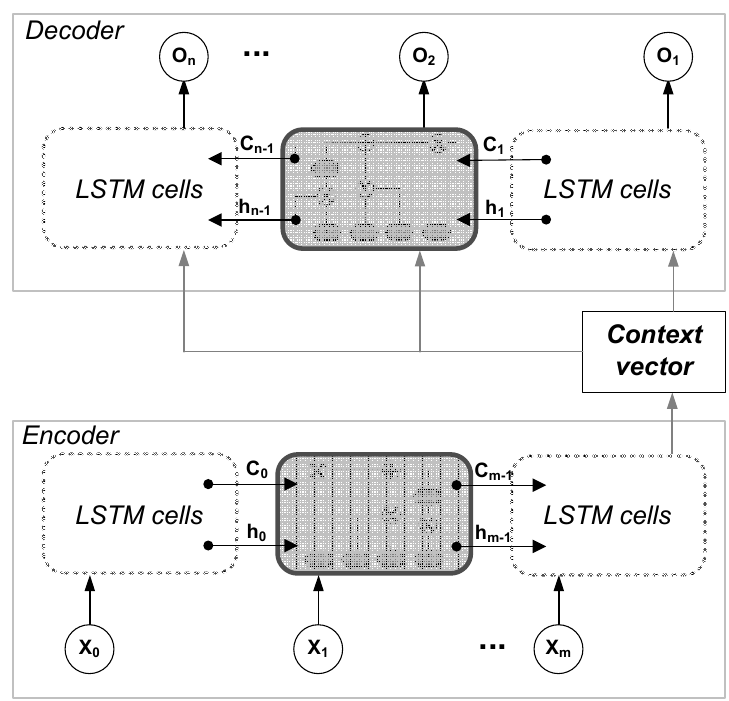
Figure 3. Conceptual diagram of LSTM with the sequence-to-sequence structure model.